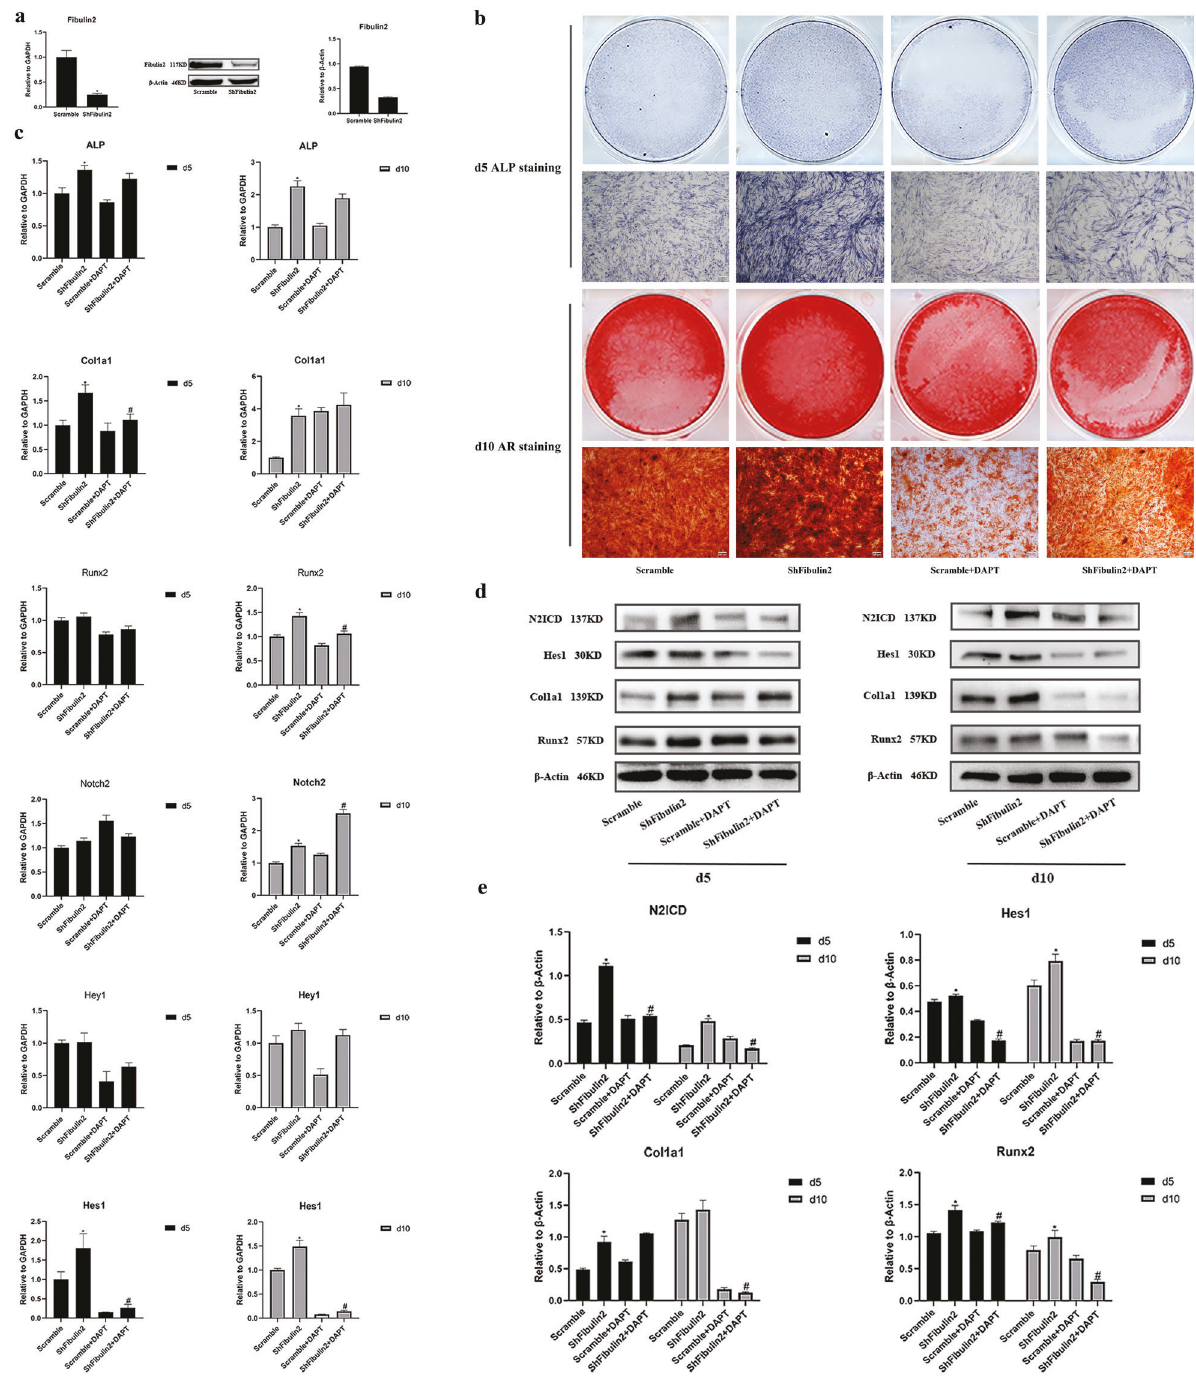
Fig. 6 Fibulin2 knockdown enhances BMSC osteogenesis, and excessive osteogenesis is abolished by DAPT. a Effective knockdown of Fibulin2 in BMSCs was con fi rmed by RT – qPCR and western blotting (WB). b Alkaline phosphatase (ALP) staining on Day 5 and alizarin red staining (ARS) on Day 10 were performed after the BMSCs were transfected with different lentiviruses during osteogenic differentiation. Alp staining and ARS were more intense on Days 5 and 10, respectively, in the shFibulin2 group than in the scramble group, while DAPT reversed the increased osteogenic differentiation, as evidenced by less intense staining in the scramble + DAPT and shFibulin2 + DAPT groups. c The mRNA expression of osteogenic differentiation-related genes (ALP, Runx2, and Col1a1) and Notch2 pathway-related genes was upregulated in the shFibulin2 group compared to the control group and was decreased after DAPT treatment. (*the shFibulin2 group vs. the control group, P < 0.05; #the shFibulin2 + DAPT group vs. the shFibulin2 group, P < 0.05; n = 3). d WB indicated that BMSCs expressing shFibulin2 had higher protein expression of Hes1, N2ICD, Runx2 and Col1a1; however, the expression of these proteins was decreased in the DAPT treatment group. e Quanti fi cation of the WB data. (*the shFibulin2 group vs. the control group, P < 0.05; #the shFibulin2 + DAPT group vs. the shFibulin2 group, P < 0.05; n = 3). Scramble: BMSCs transfected with control lentivirus; shFibulin2: BMSCs transfected with lentivirus harboring shRNA targeting